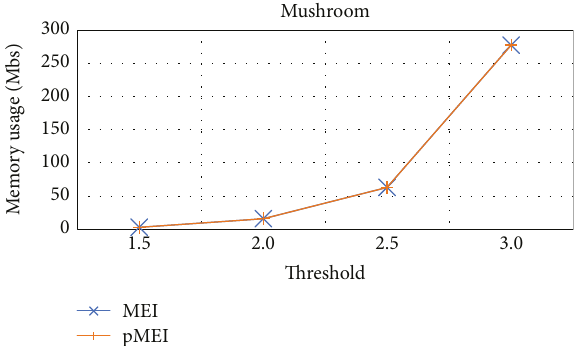
Figure 11: Memory usage of the MEI and pMEI methods on the Mushroom.